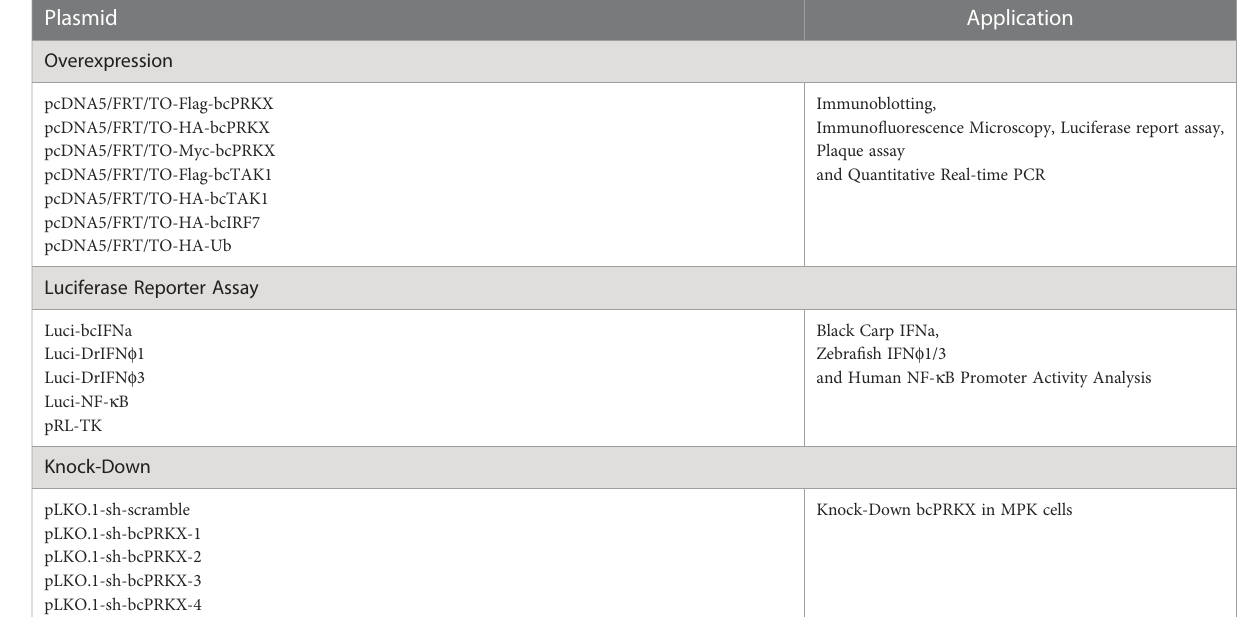
TABLE 1 Plasmids used in this